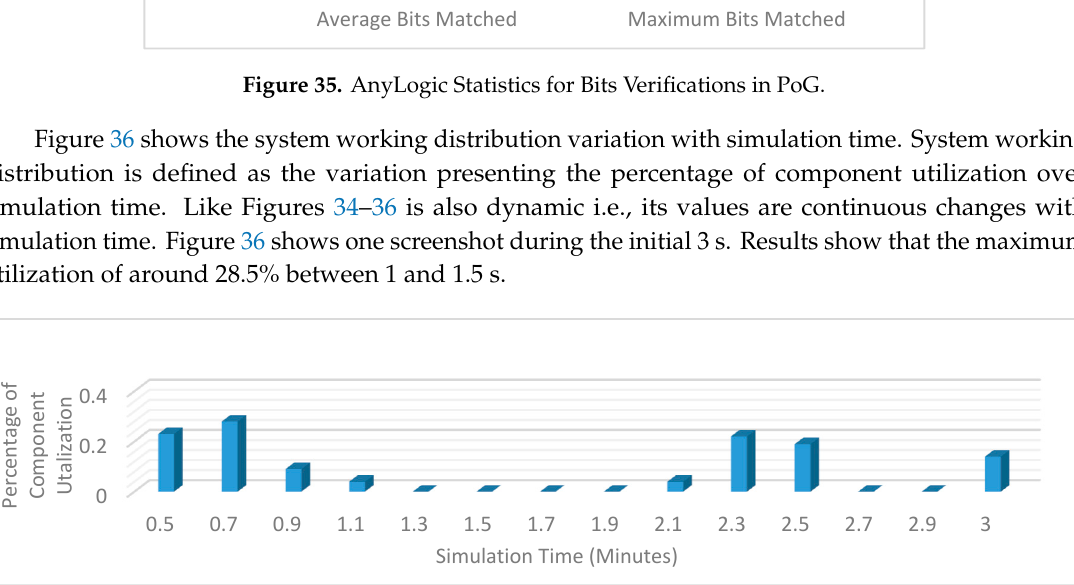
Figure 36. System Working Distribution Variations with simulation time.